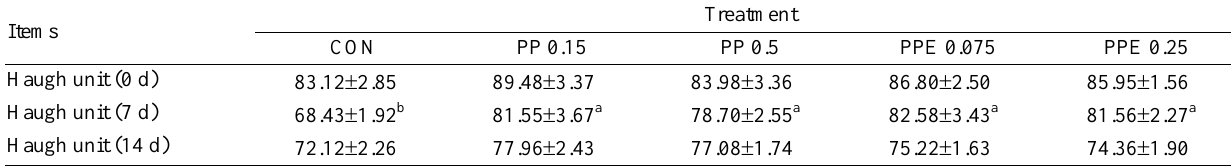
Table 4. Effects of persimmon peel (PP) and persimmon peel ethanol extract (PPE) on the change of Haugh unit in laying hens 1